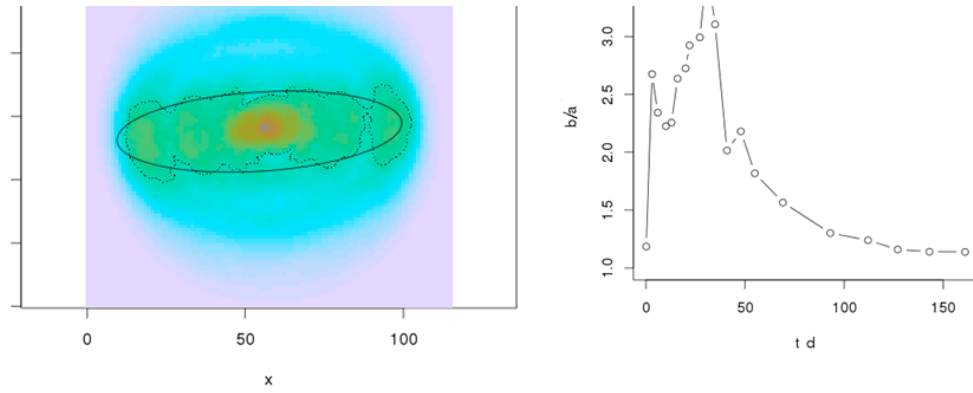
Figure 12. Left: axial projection of the activity distribution with elliptical fit of the FWHM curve of the ninth frame after 27 days (see Fig. 8). Right: temporal evolution of the ratio of the major anisotropy